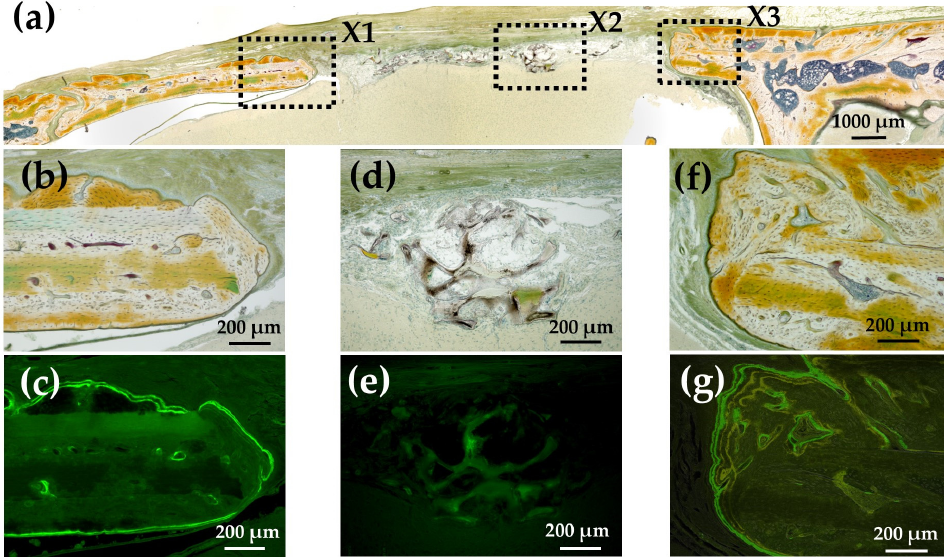
Figure 15. ( a ) Villanueva-stained image of a rat cranial bone defect filled with an AG-infiltrated and b-FGF-loaded Col/Hap composite (AI 20 min 5Cy Col/Hap + AG + b-FGF) (4× magnification). ( b ) Magnified image of “X1” in Figure 15a. ( c ) CL-fluor-labeled images of Figure 15b; ( d ) magnified image of “X2” in Figure 15a. ( e ) TC&CL-fluor-labeled image of Figure 15d. ( f ) Magnified image of “X3” in Figure15a. ( g ) TC&CL-fluor-labeled image of Figure 15f (10× magnification).